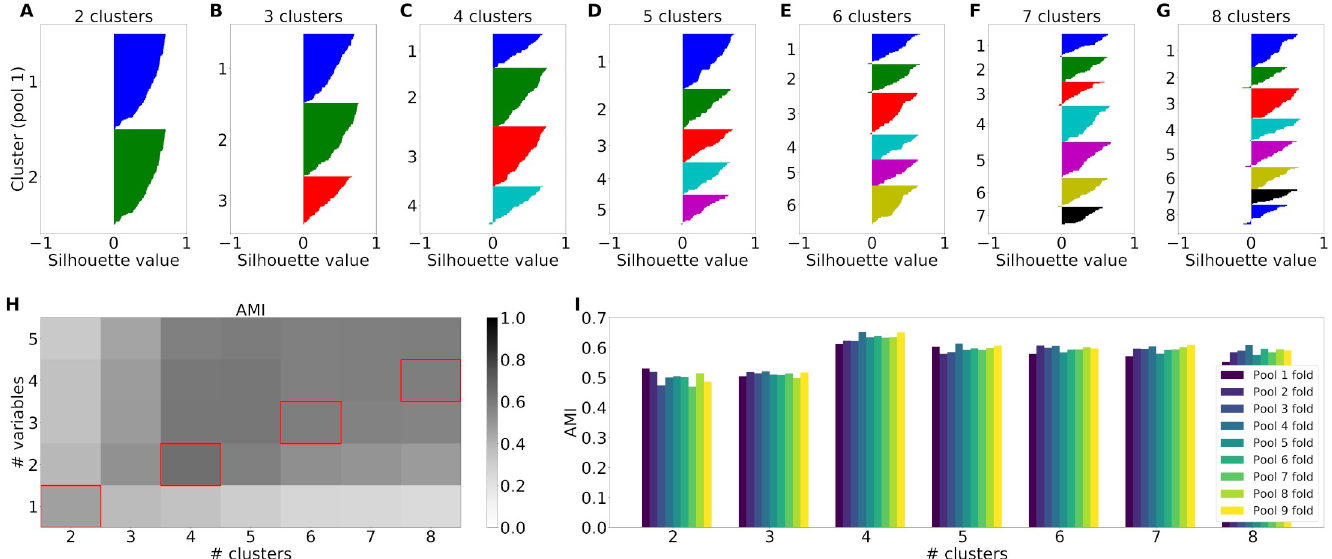
Fig 7. Cluster results for real data recorded from macaque orbitofrontal cortex limited to the post-juice time window. (A)-(G) Silhouette plots for the spherical k- means partitions of one example pool (pool 1). Each color corresponds to one cluster. The number of clusters was varied between 2 (A) and 8 (G). (H) Adjusted mutual information cluster similarity between spherical k-means clustering and variable-based centroid clustering as a function of the number of clusters and number of variables over all pools. Corresponding numbers of clusters and numbers of variables are marked in red. (I) Maximum adjusted mutual information for each number of clusters where each bar shows the result of one Jackknife